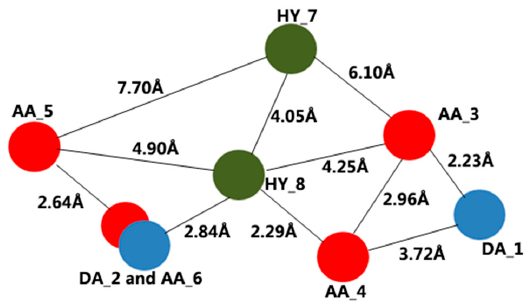
Figure 2. Obtained pharmacophore model consisting of two donor atom centers (DA), four acceptor atom centers (AA) and two hydrophobic groups (HY).